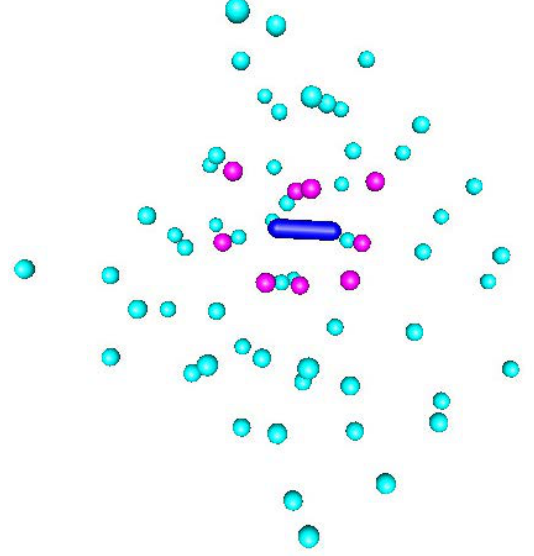
Figure 1. Start of simulation 2 after the equilibration, side view. Blue: nitrogen, red: hydrogen, magenta: lithium.